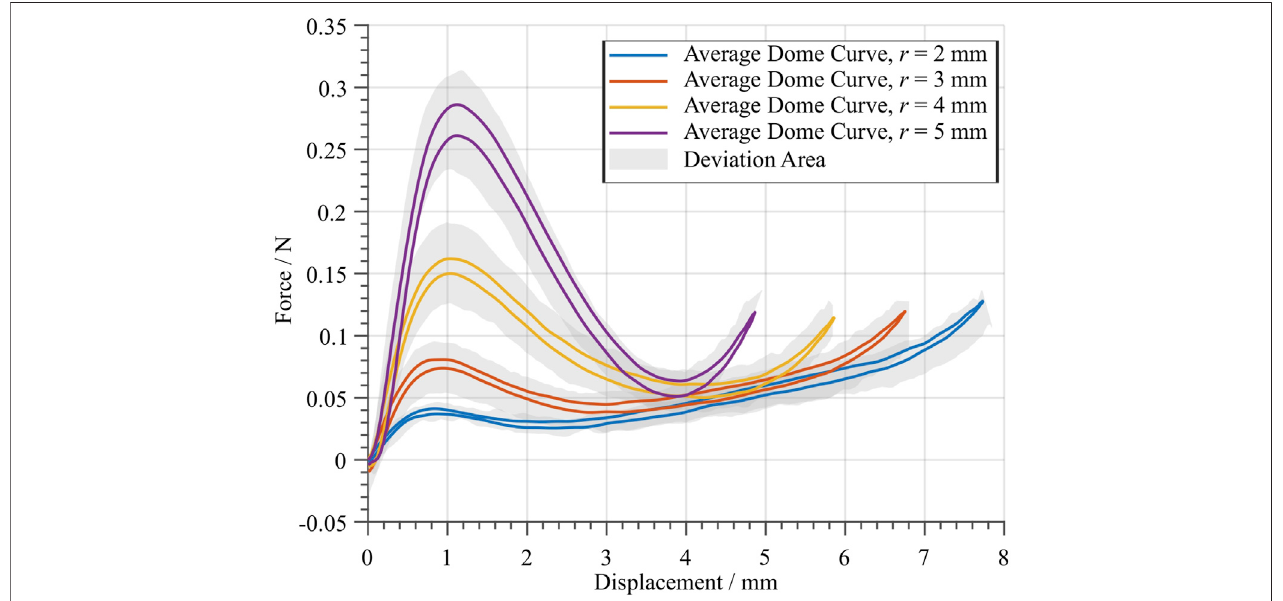
FIGURE 6 | Average force-displacement curves of four different dome geometries. A total of eight batches were manufactured with three different molds, having the same geometry. Each solid curve is computed based on the average behavior between eight specimen, which all share the same nominal geometry. The gray area shows the maximum and minimum deviation of the measured